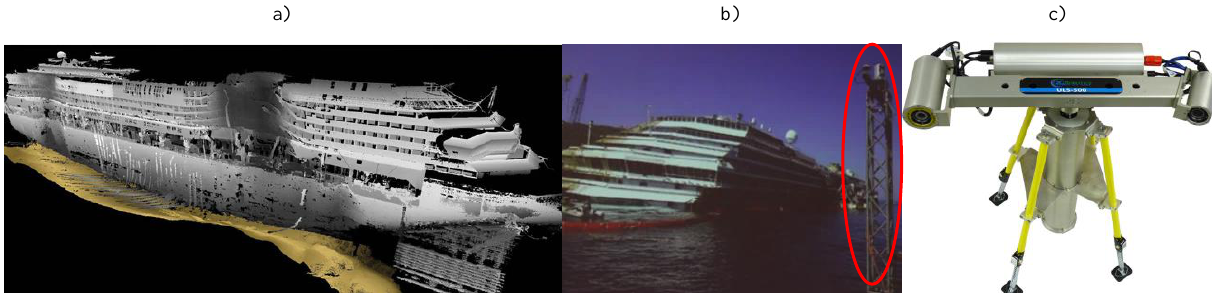
Figure 3. Combined laser survey, above and below the water, of Costa Concordia wreck (a) conducted by “ADUS DeepOcean” using a pole (b) (http://www.teledyne-reson.com/news/video-paper-high-quality-surveys-of-man-made-structures-by-adus/); the underwater triangulation based laser scanner developed by 2G Robotics (http://www.2grobotics.com/products/underwater-laser-scanner-uls-500/) used for the survey